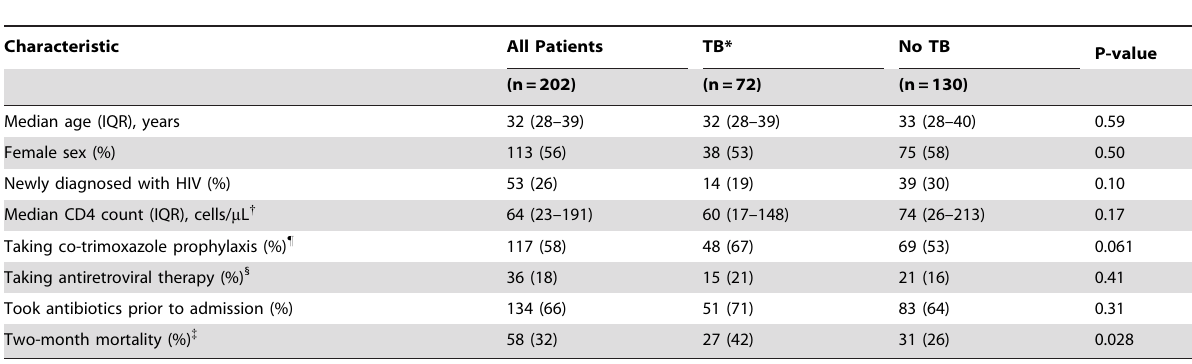
Table 1. Demographic and clinical characteristics of the 202 study